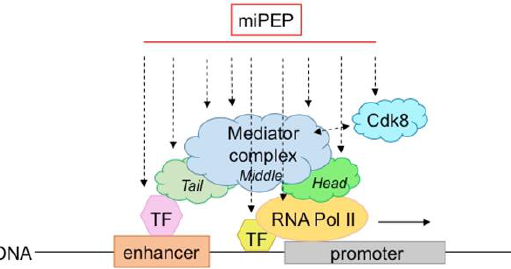
Figure 3. Model of possible miPEP interactions/crosstalk within the transcriptional machinery. MiPEPs might interact with different subunits/regions of the mediator or RNApolII complexes.